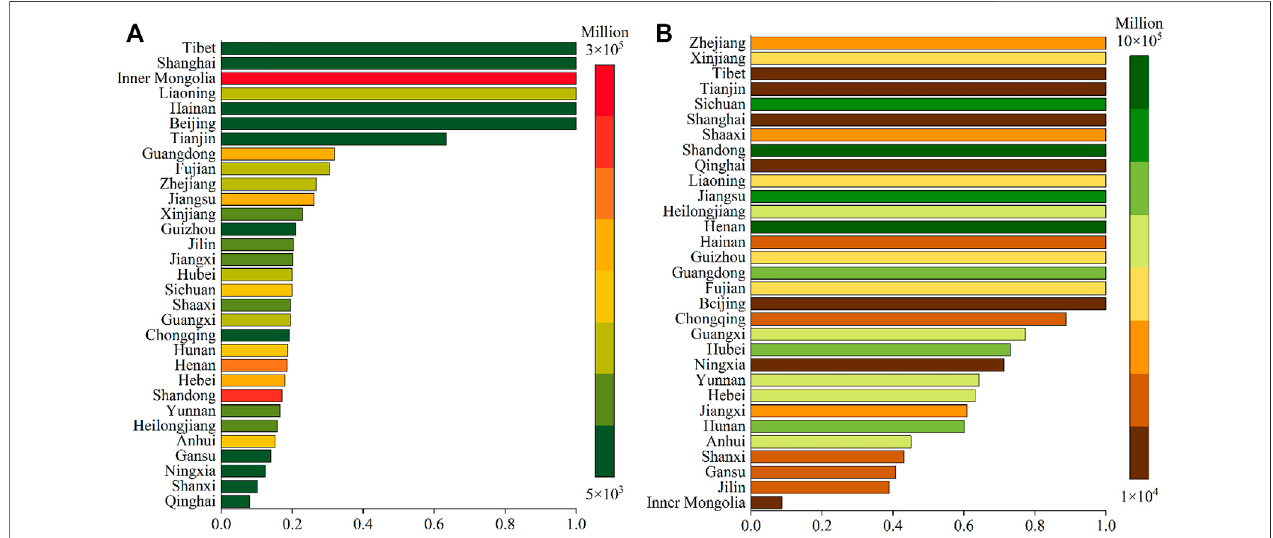
FIGURE 1 | Agricultural Eco-ef fi ciency in China from 2001 – 2019 [ (A) : 2001, (B) : 2019].